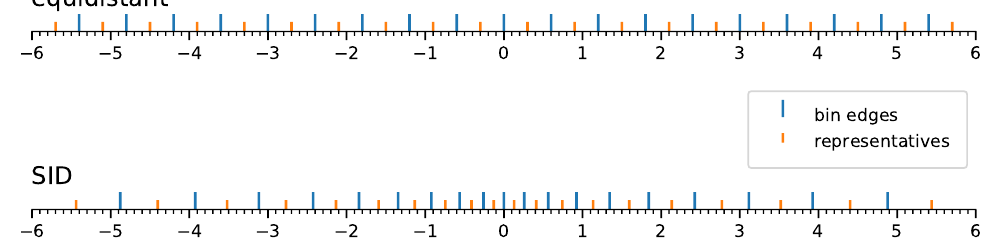
Figure 2. Two number lines with markers for bin edges and their representative values visualizing the difference between equidistant binning ( top ) and spacing-increasing discretization ( bottom